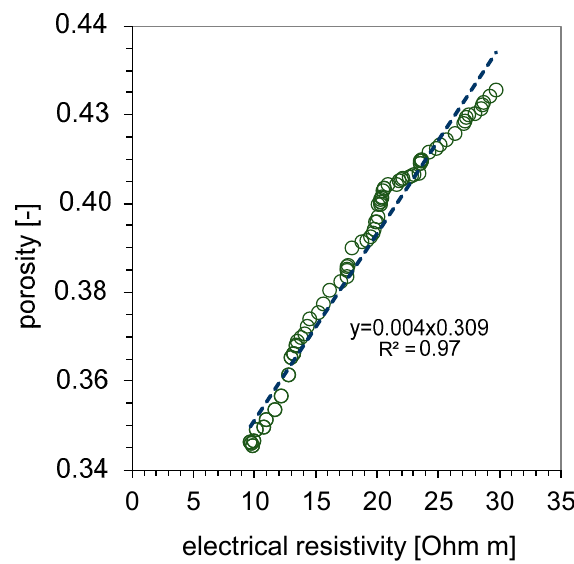
Figure 9. Analytical relation between electrical resistivity and porosity of sandy clay (sisaCl) based on oedemeter tests.